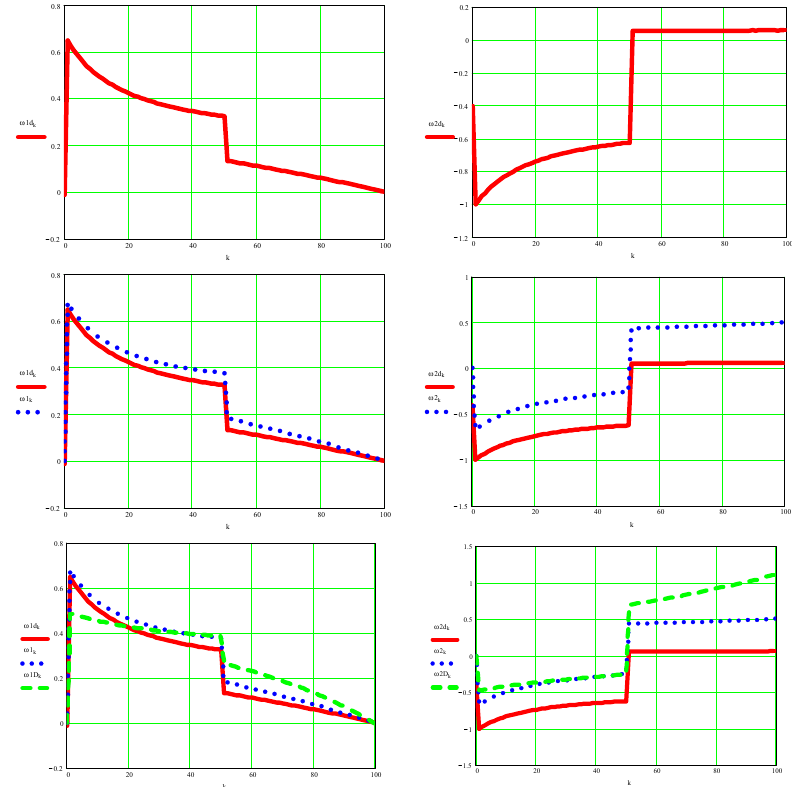
Figure A14. In the upper part are represented the dynamic angular speeds obtained with the new method presented in the paper, marked with d, on the left for the motor element 1 and on the right for the motor element 2; then below you can see the same dynamic speeds compared to the kinematic ones; in the end, bottom, all three will be compared, ie the dynamic angular velocity obtained by the absolutely new method (d), the kinematic angular velocity, and the dynamic angular velocity (D) determined by a classical method substantially improved by the author.